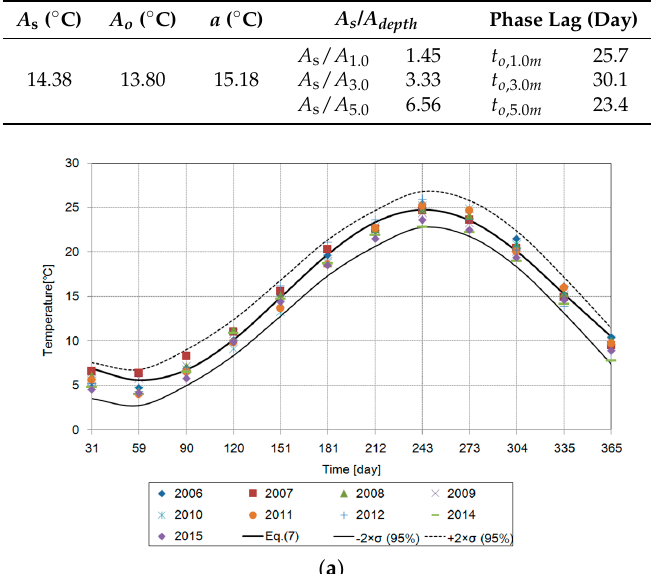
Table 2. Coefficients for estimating ground temperature in Incheon, Korea.